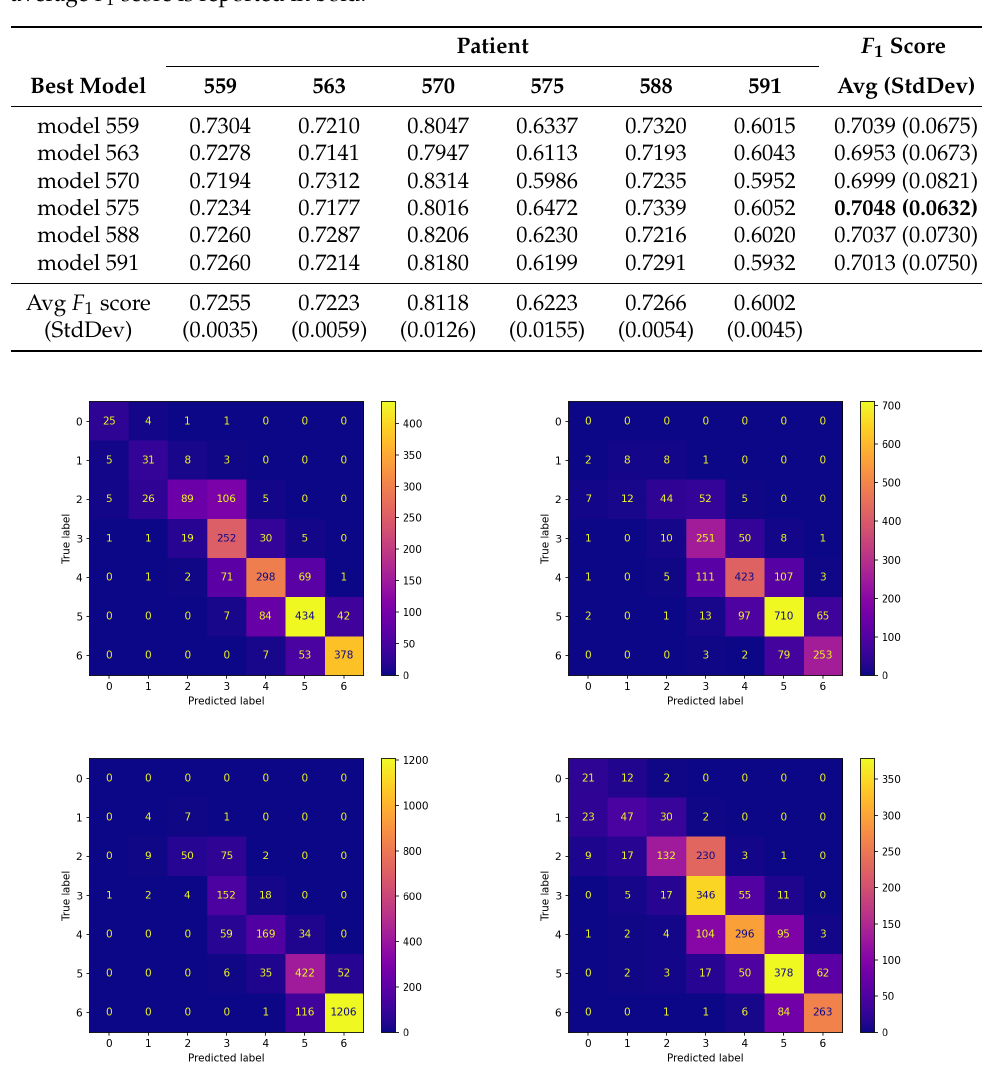
Table 6. Results of the FLEA algorithm with a communication frequency equal to 100. The best average F 1 score is reported in bold.